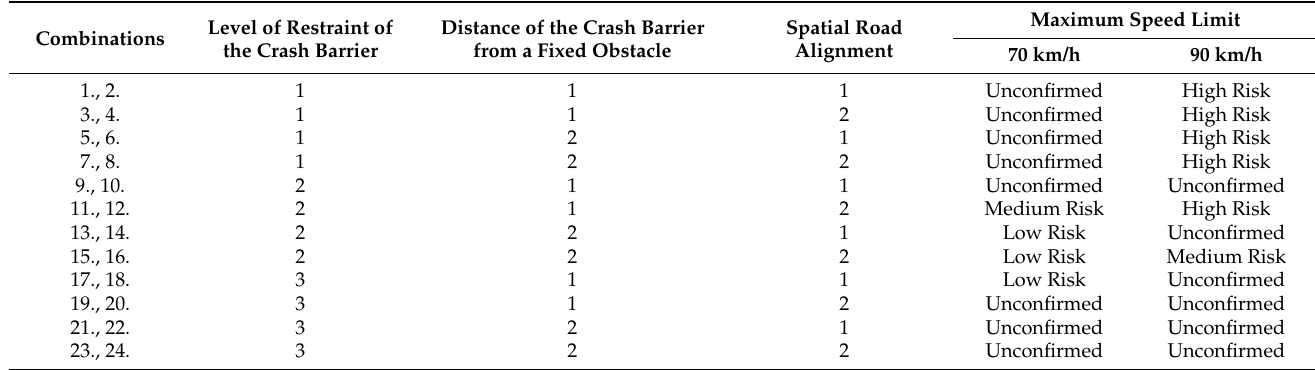
Table 15. Hypothesis III.—Insufficient minimum distance behind the crash barrier. Level of Restraint of Combinations the Crash